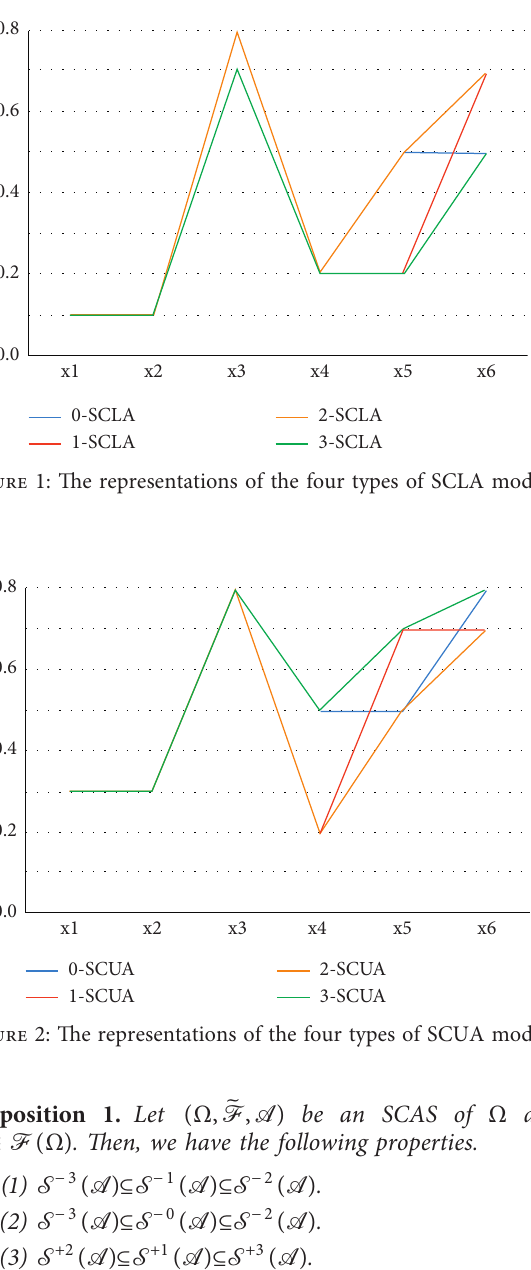
Table 4: Table for D 3